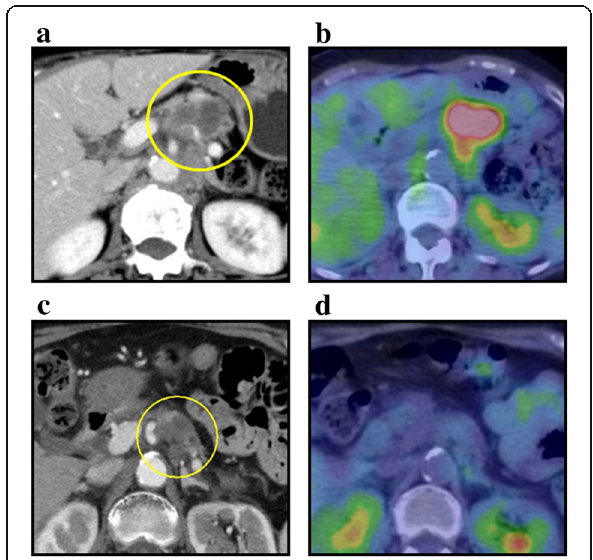
Fig. 1 An enhanced CT revealed a 45-mm tumor in the body of pancreas ( a ). The SUV (max) of the tumor was 6.2 in a PET-CT ( b ). After the chemoradiation for 15 months, the size of the primary tumor was reduced to 25 mm ( c ). The abnormal uptake in a PET-CT disappeared ( d )